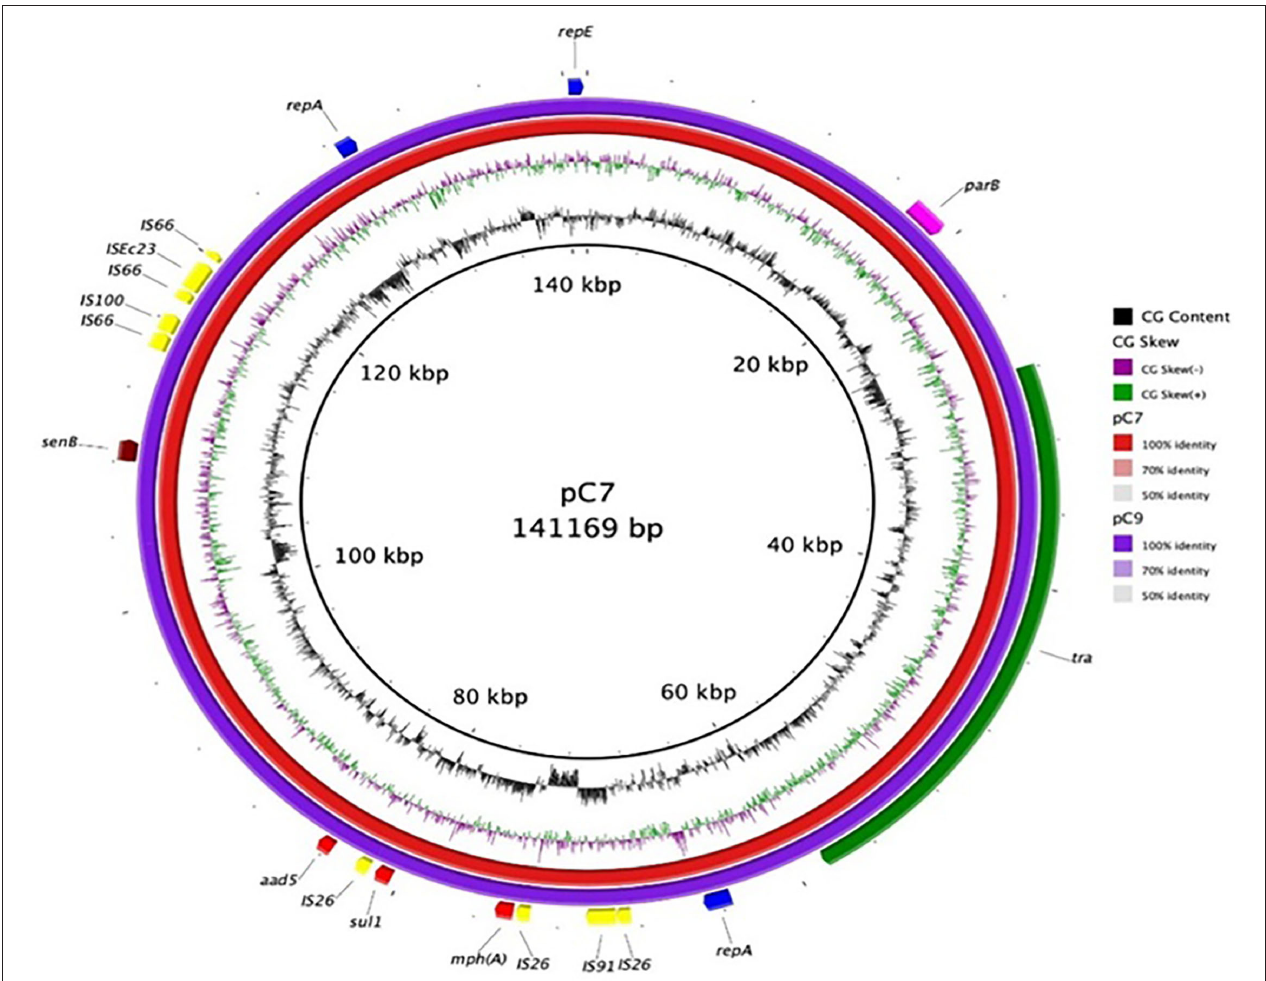
FIGURE 9 | Plasmid map of C7 and C9-3 E. coli . Each ring represents the nucleotide sequence of the plasmids of the two E. coli isolates as indicated by the color code. Gene annotation of the reference plasmid pC7 is shown in the outer ring. Colored arrows indicate the genes, mph(A) (macrolide 2 ′ -phosphotransferase), sul1 (dihydropteroate synthase), senB (enterotoxin), repA (regulatory protein), repE (replication initiation protein), parB (centromer binding protein), and aad5 (aminoglycoside adenyl transferase).